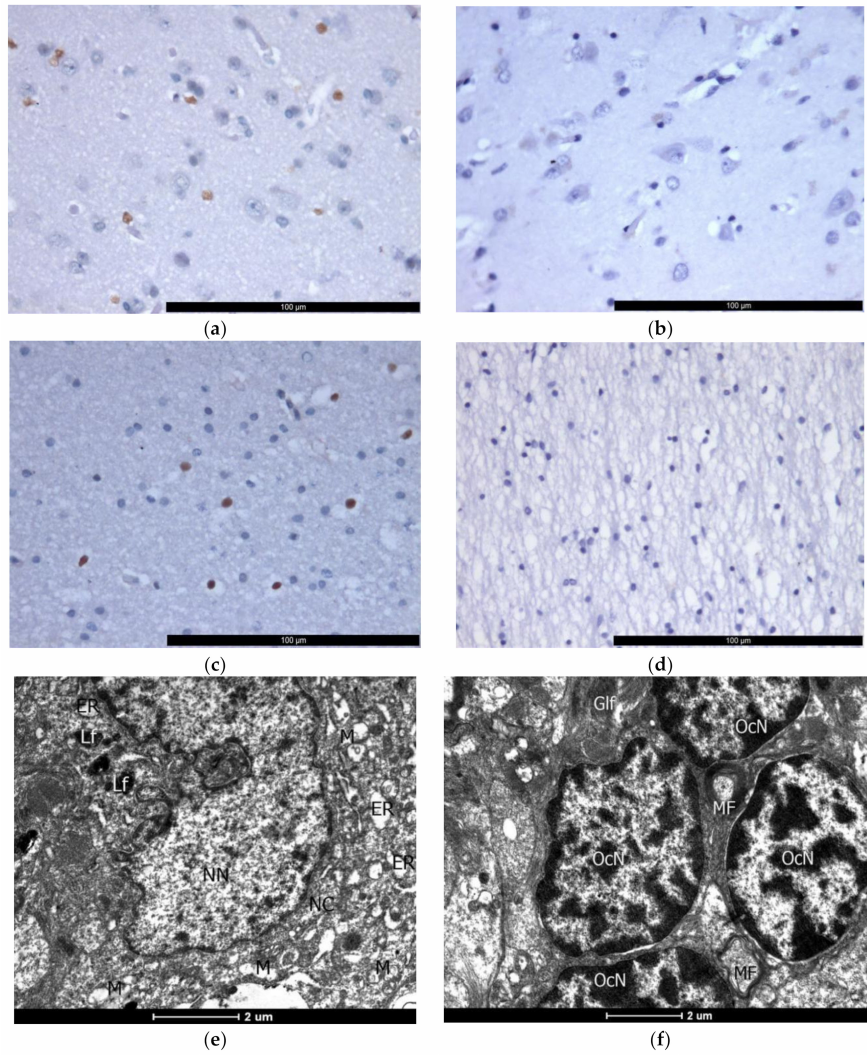
Figure 2. Study of cell apoptosis in the epileptic focus of the temporal lobe. Light microscopy, IHC study of cell apoptosis in the epileptic focus of the temporal lobe: ( a ) the presence of active caspase-3 in glial cells in the cortex of patients with DRE (brown staining in the cell nucleus); ( b ) absence of the active caspase-3 in the cortex cells of patients in the comparison group (without epilepsy); ( c ) the presence of active caspase-3 in glial cells in the white matter of patients with DRE (brown staining in the cell nucleus); ( d ) absence of the active caspase-3 in the white matter cells of patients in the comparison group (without epilepsy), 400 × . TEM, the initial stage of apoptosis: ( e ) cortical neuron with an elongated, curved nucleus (NN, neuron nucleus), finely condensed chromatin fragments in the karyoplasm, destructively altered mitochondria (M) in the cytoplasm (NC, neuron cytoplasm), dilated tubules of the endoplasmic reticulum (ER) and lipofuscin granules (LF); bar, 2 µ m; ( f ) an accumulation of oligodendrocytes in the white matter of the brain, the heterochromatin of which is distributed throughout the nucleus (OcN, oligodendrocyte nucleus) in large conglomerates. GlF, glyofibrils; MF, myelin fibers; bar, 2 µ m; 8200 ×